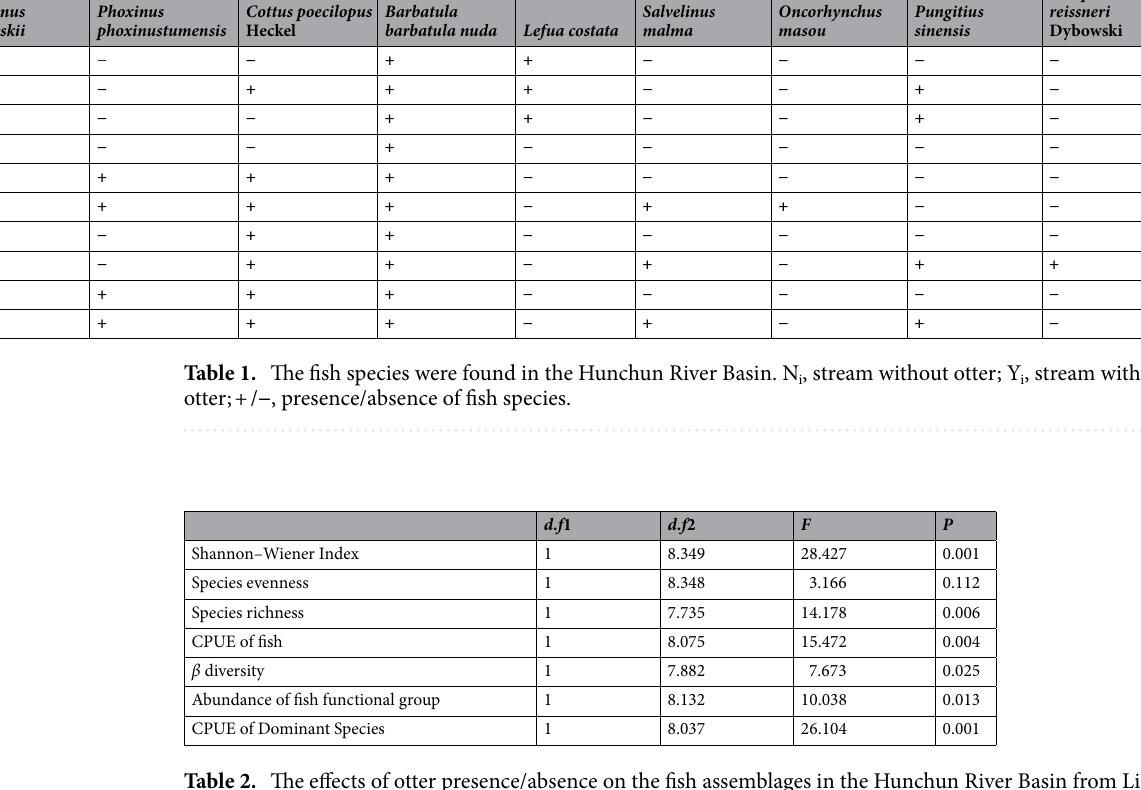
Table 2. The effects of otter presence/absence on the fish assemblages in the Hunchun River Basin from Liner Mix Models (LMMs). CPUE = Catch Per Unit Effort (1 h); Dominant Species: P.lagowskii; d.f. = degrees of freedom, F = F